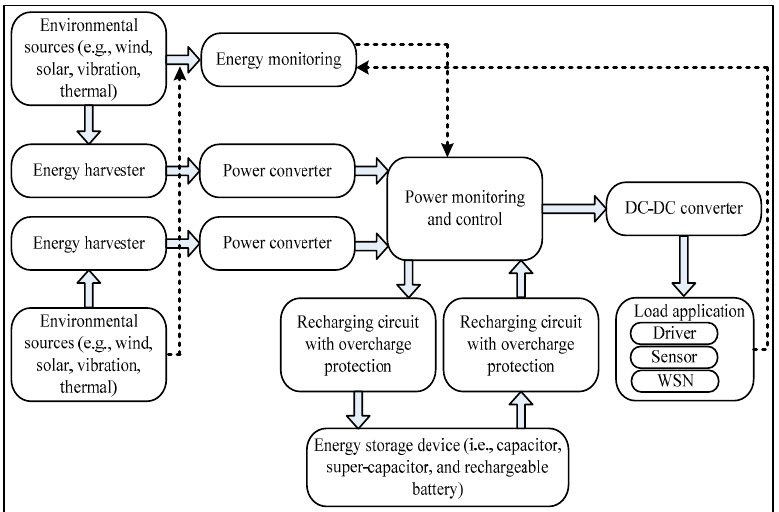
Figure 1. Block diagram of a dual-source energy harvesting system.